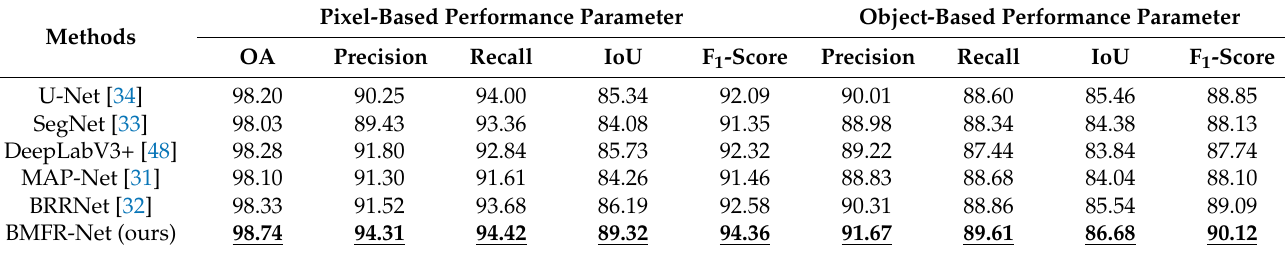
Table 2. Quantitative evaluation (%) of several SOTA methods on the WHU Building Dataset. The best metric value is highlighted in bold and underline. Pixel-Based Performance Parameter Object-Based Performance Methods